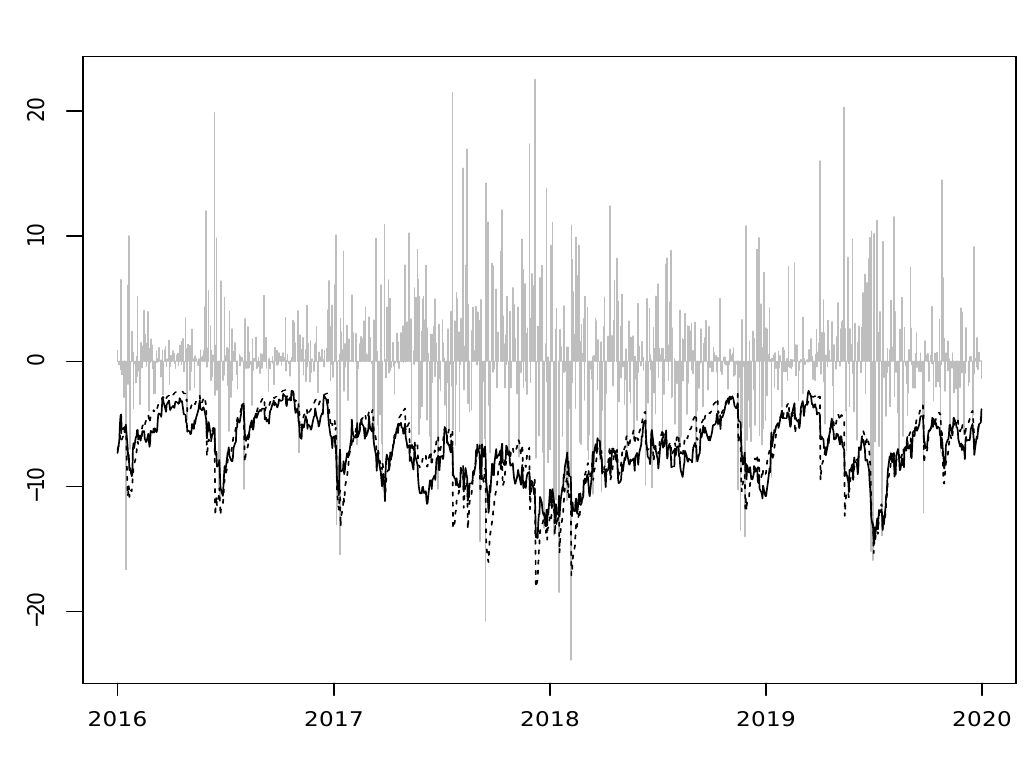
Figure 7. Plot of estimated 95% value-at-risk (VaR) for Bitcoin return data superimposed on log returns. Solid line shows VaR estimated using the VT(2)-ARMA(1,1) model combined with a double-Weibull marginal distribution; the dashed line shows VaR estimated using a GARCH(1,1) model with GED innovation